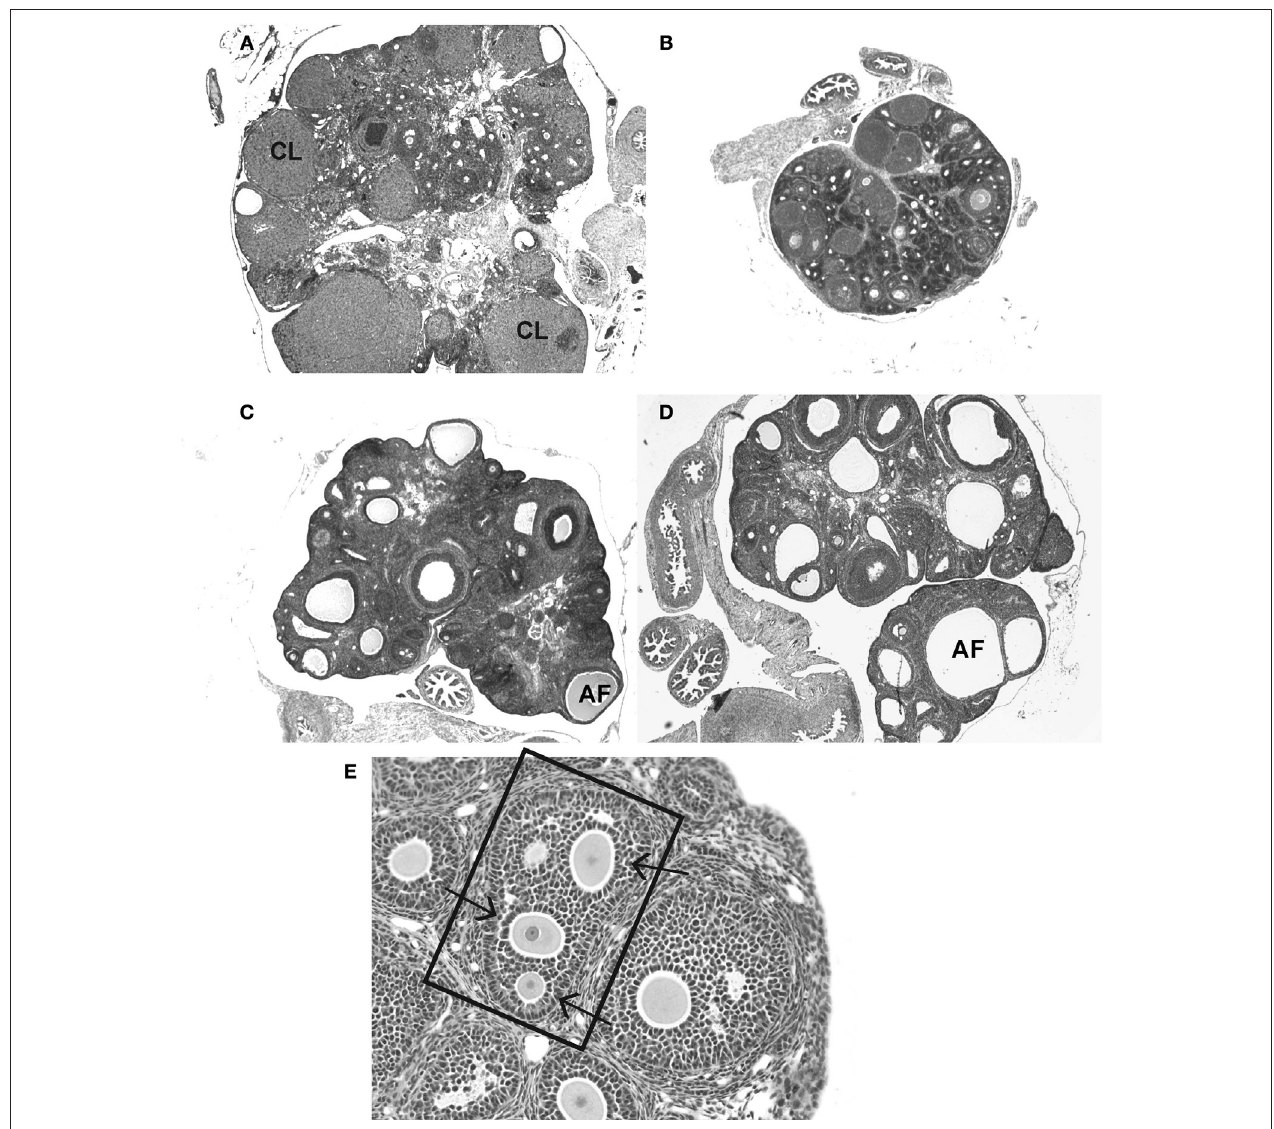
FIGURE 2 | Frequently observed ovarian malformations in rats following neonatal exposure to endocrine disruptors. (A) An ovary from an unexposed adult female contains follicles at all stages of folliculogenesis and numerous corpora lutea (CLs), indicative of successful ovulation. (B) Ovaries from